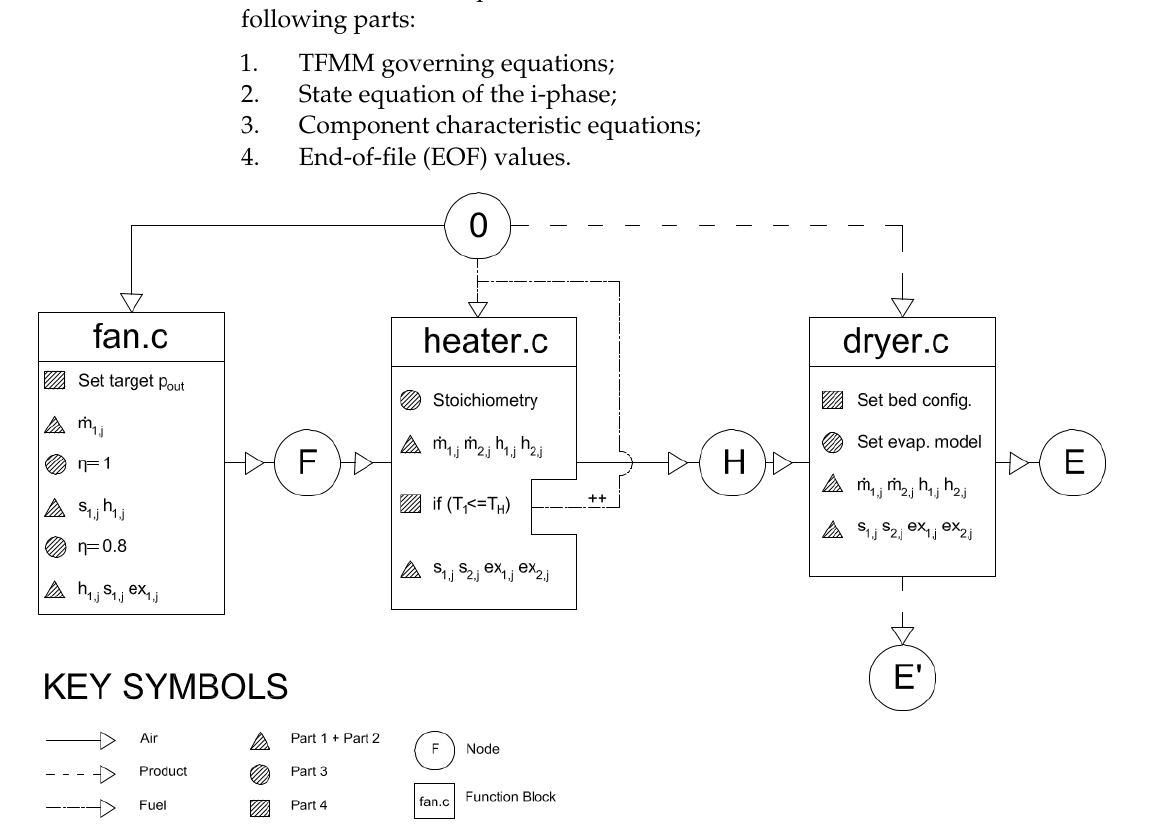
Figure 3. Solving algorithm applied to the baseline